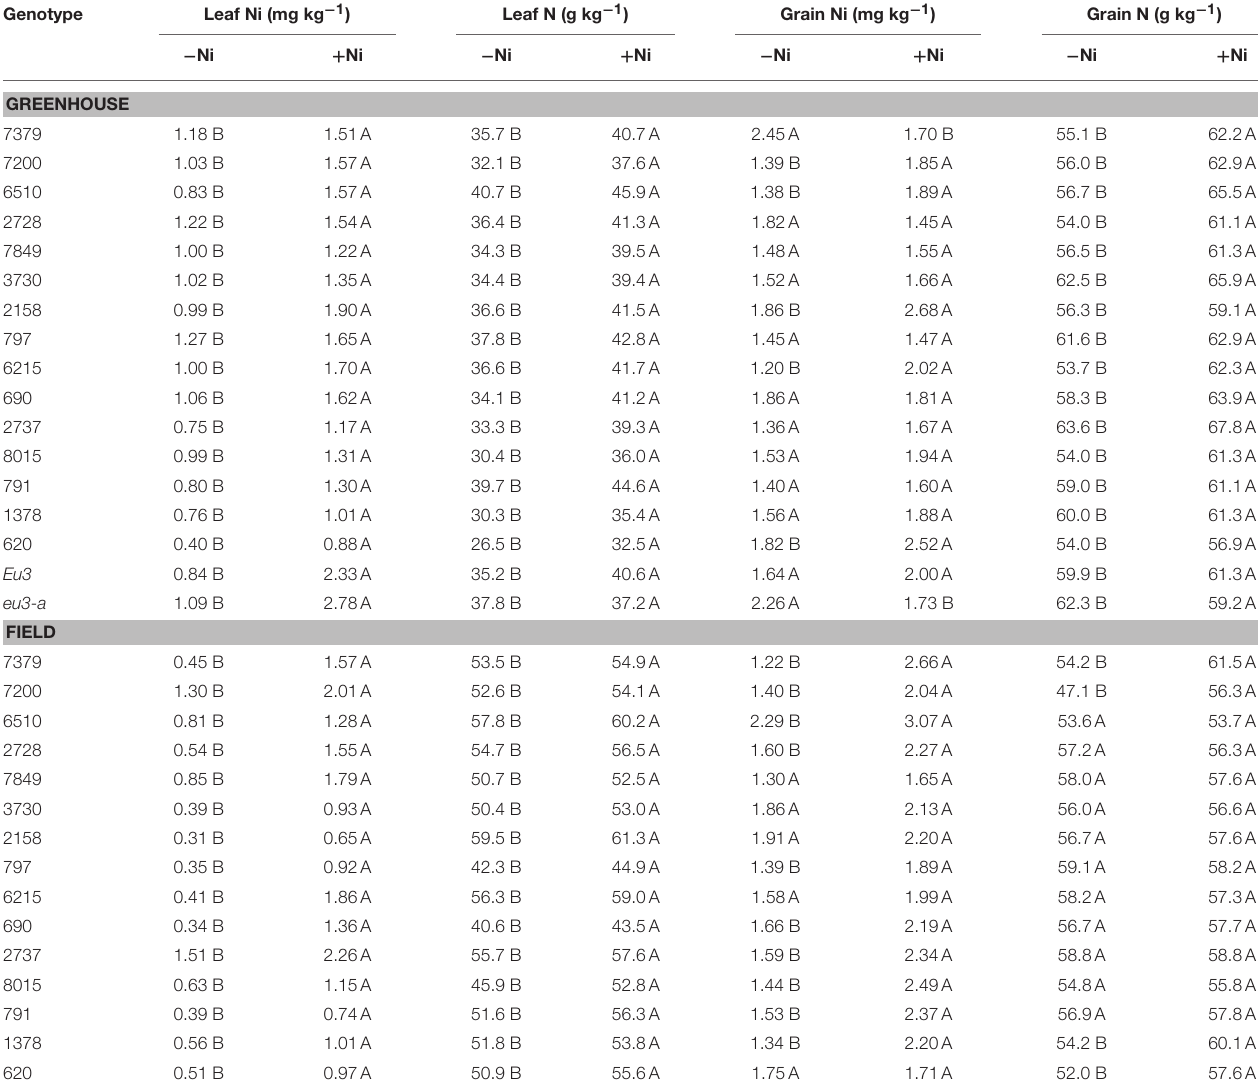
TABLE 4 | Effects in leaf Ni and N concentration and grain Ni and N concentration due to fertilization with 0.0mg of Ni kg − 1 ( − Ni) and 0.5mg of Ni kg − 1 ( + Ni) in 15 soybean genotypes and two near-isogenic lines (NILs, Eu3 and eu3-a ) cultivated in greenhouse and field conditions.